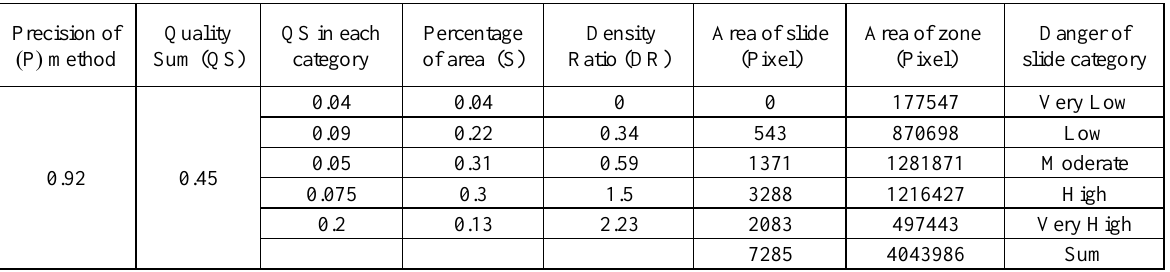
Figure 6. The area of different classes of risk for Fuzzy-AHP models, gamma of 0.975 and OR operator Validation and accuracy of landslide hazard zonation models for evaluated using DR, QS and method P parameter quantified and Fuzzy-AHP models, gamma of 0.975 and OR operator have been the results have been depicted as tables 2 to 4. Table 2. Validation and accuracy of landslide hazard zonation using Fuzzy-AHP model